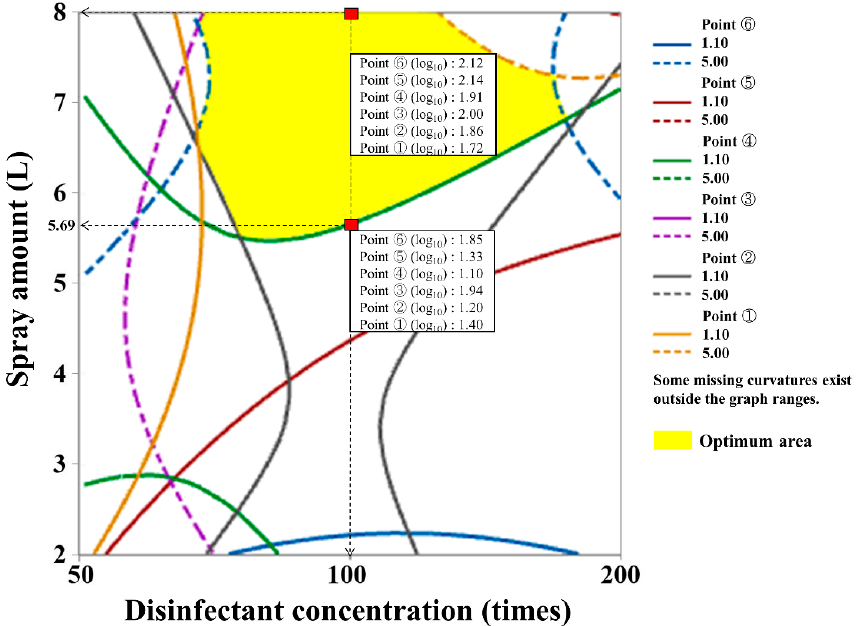
Figure 9. Overlay plot of the disinfectant concentration and spray amount on the disinfection efficiency at each point when the room size is 300 m 3 .